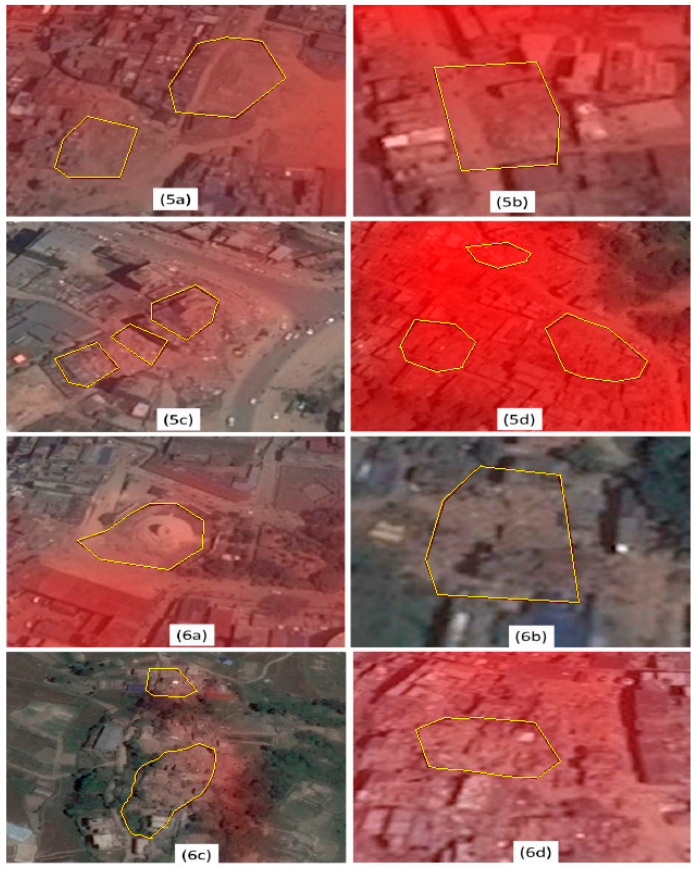
Figure 7. The NASA Damage Proxy Map (NDPM) in a number of highly damaged locations overlaid on the Google Earth imagery dated 3 May 2015 (post-seismic). The labels 5a to 5d and 6a to 6d in this figure denote the corresponding locations described in Figures 5 and 6, respectively. The amount of redness in the NDPM imagery indicates severity of building damage.